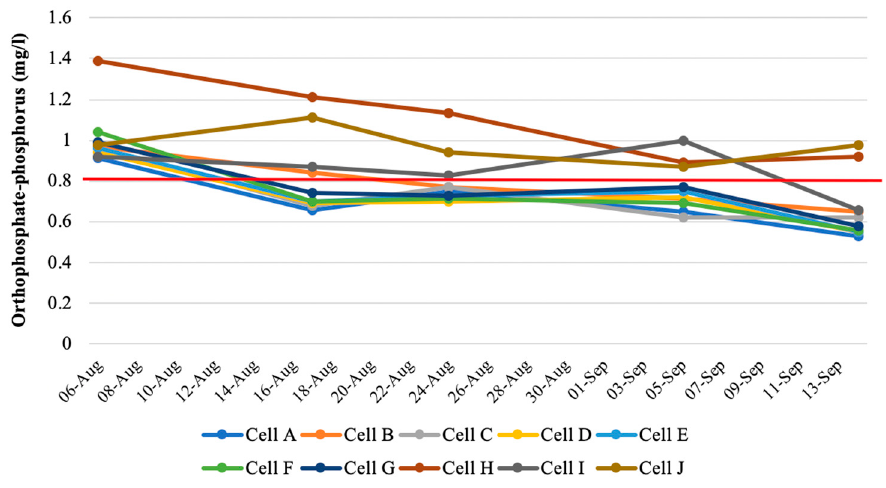
Figure 13. Variation in the orthophosphate-phosphorus concentrations with time.